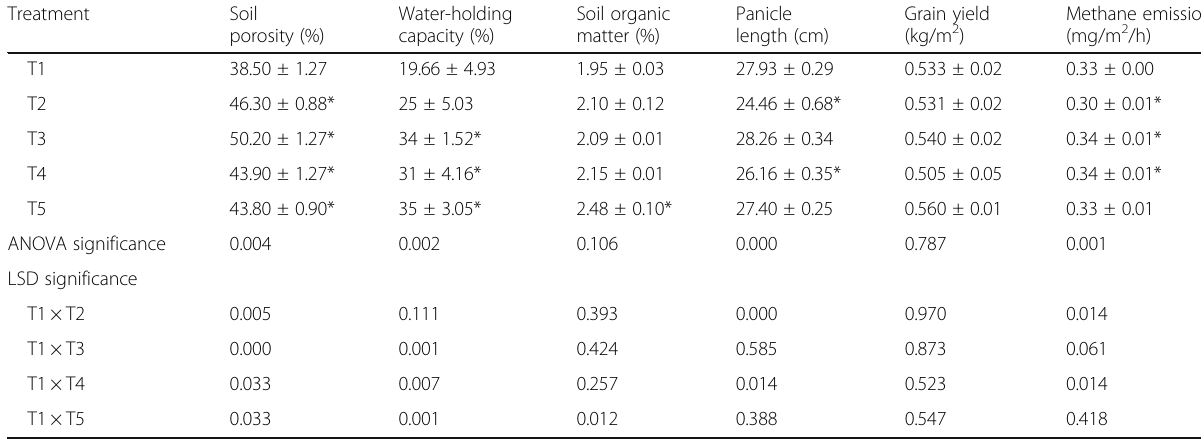
Table 5 One way-ANOVA and LSD test-based soil properties at the harvest of the crop in the year 2015 (values marked with* indicate significant difference at a significant level of 5% in comparison to the corresponding value under T1 in the same column) Treatment Soil Water-holding porosity (%) capacity